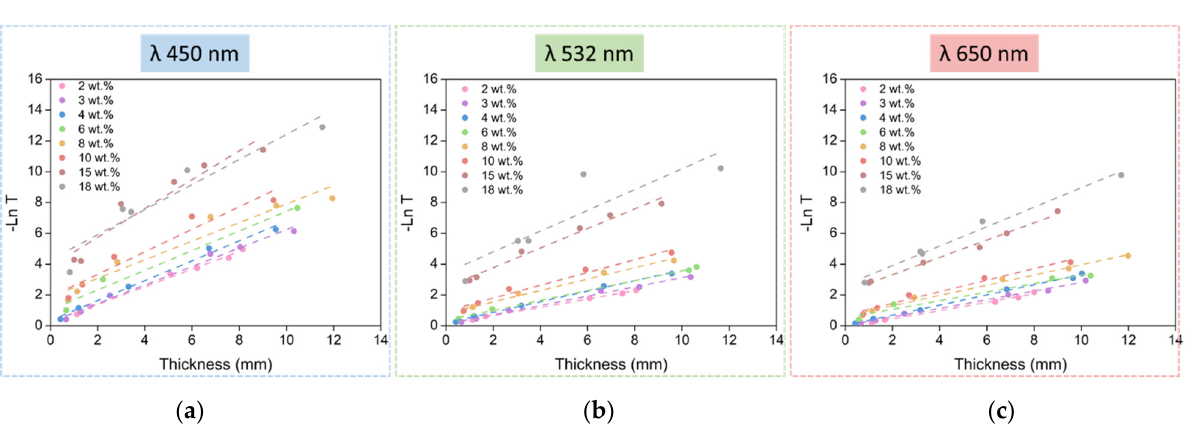
Figure 4 . − ln(T) vs. thickness for all the aerogel samples understudy at three different laser wave- lengths, ( a ) λ = 450 nm; ( b ) λ = 532 nm and ( c ) λ = 650 nm.